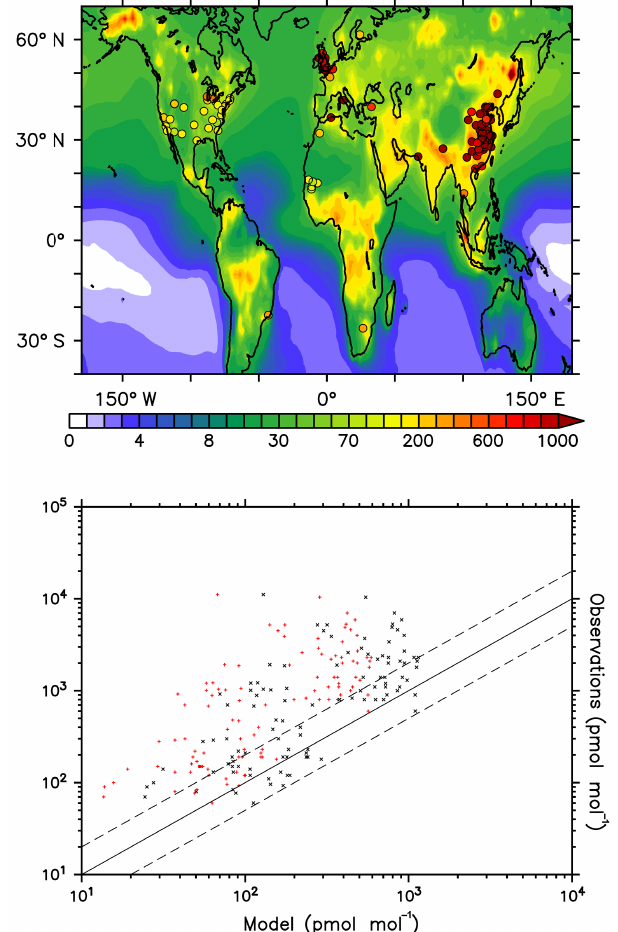
Figure 4. Top: Annually averaged surface mixing ratios of ben- zene (pmolmol − 1 ) for the RCP simulation. Circles depict obser- vations from literature. Bottom: Correlations between observations and model results. In red for the LIT scenario, in black for RCP scenario.